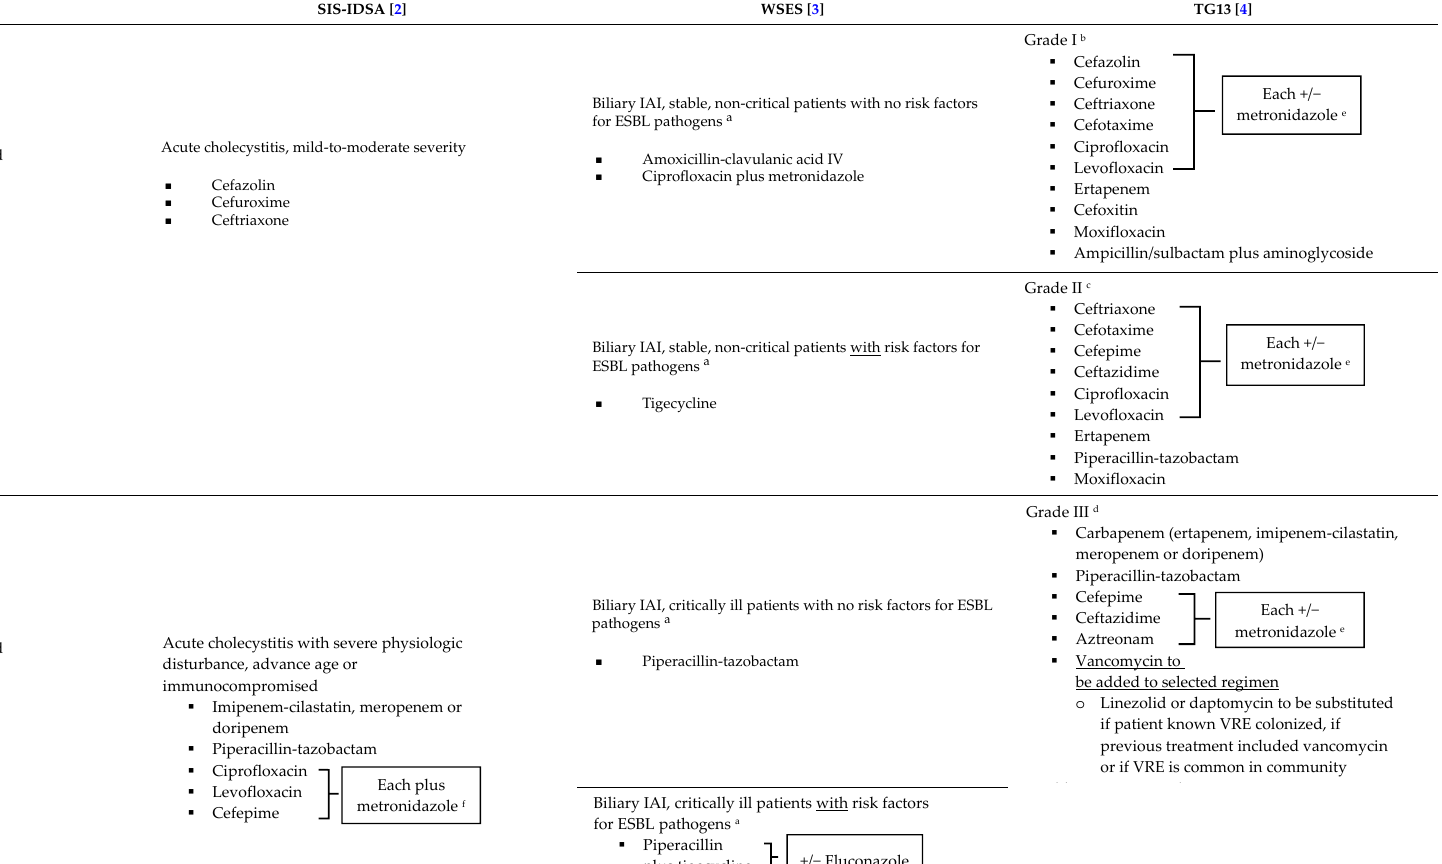
Table 1. Antimicrobial treatment recommendations for cholecystitis in adults.